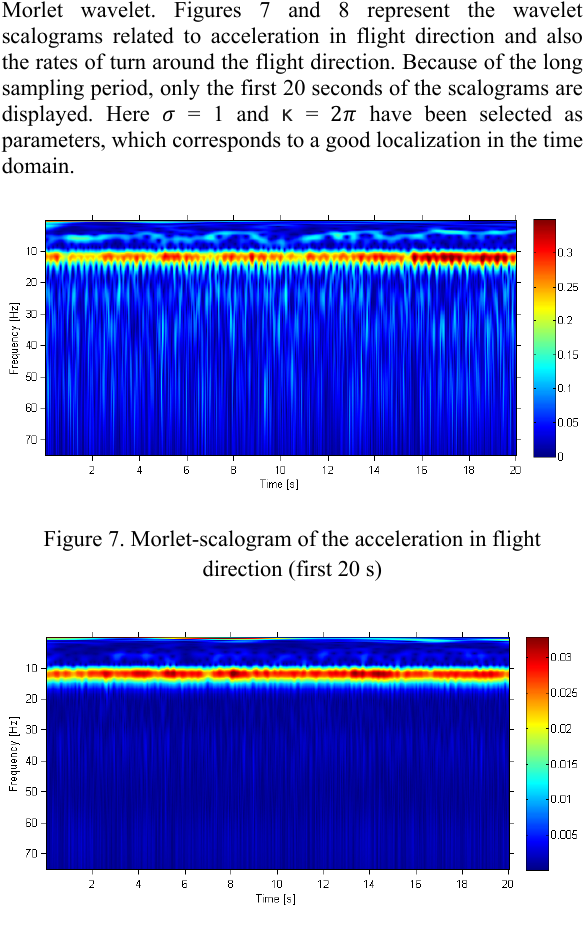
Figure 8. Morlet-scalogram of the rates of turn around the flight direction (first 20 s)